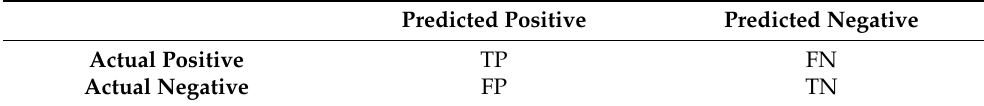
Table 6. Confusion